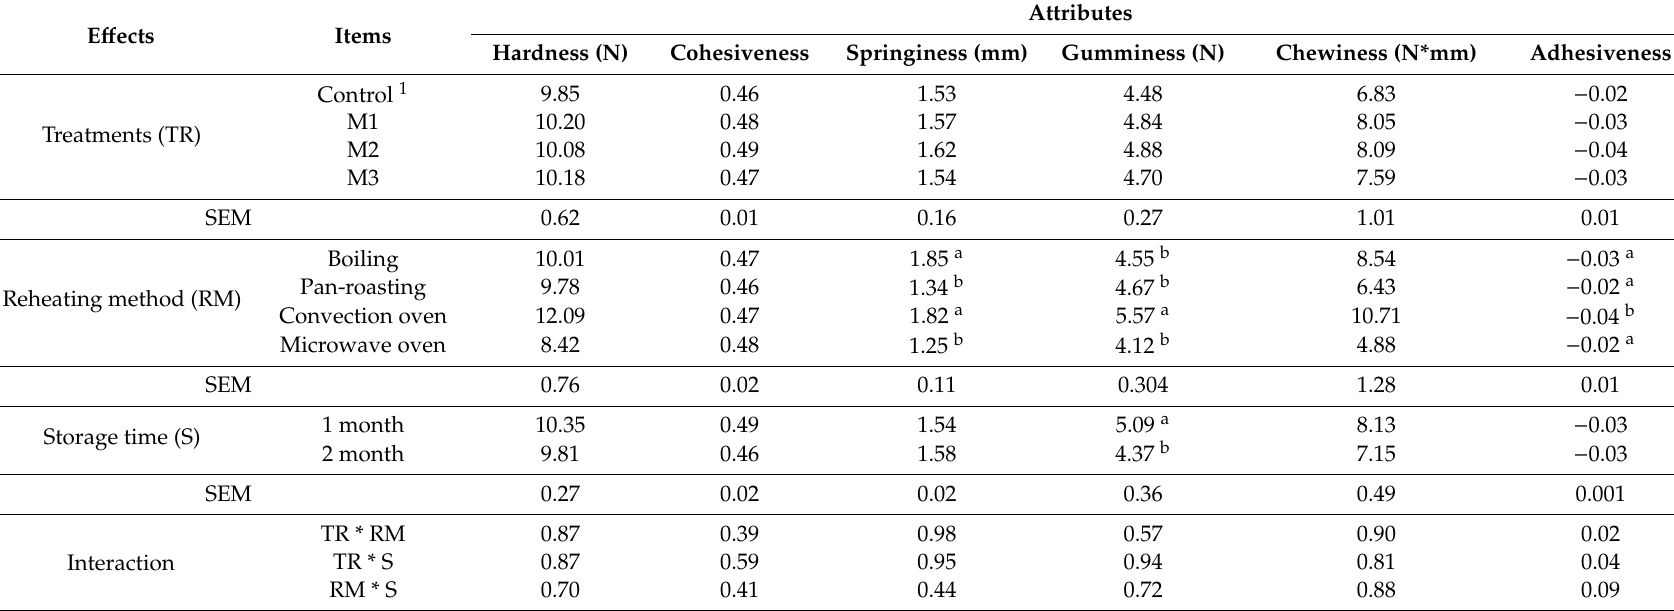
Table 4. E ff ect of di ff erent reheating condition on the texture profile analysis of nutmeg extract enriched beef meatballs during frozen